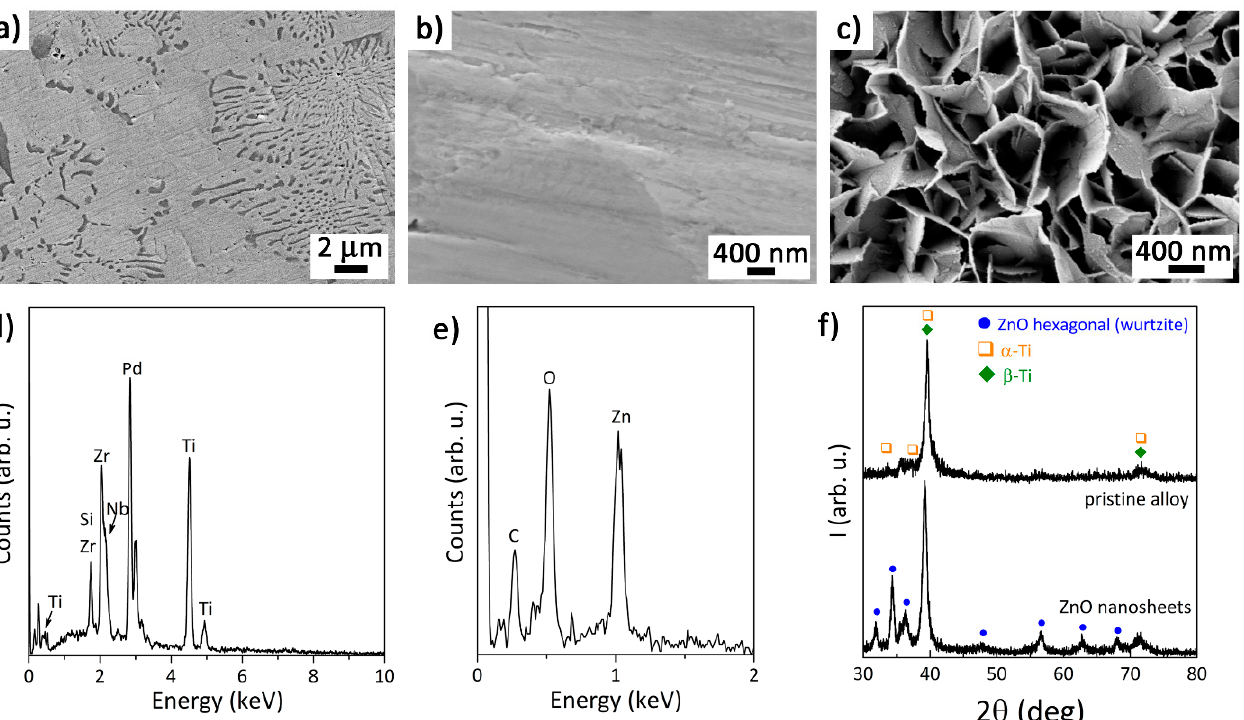
Figure 2. SEM images of ( a ) pristine alloy, ( b ) ZnO thin film, and ( c ) ZnO nanosheets deposited on top. EDX patterns of ( d ) pristine alloy and ( e ) ZnO thin film samples. ( f ) Grazing incidence X-ray diffraction (GIXRD) patterns of pristine alloy and ZnO nanosheets.